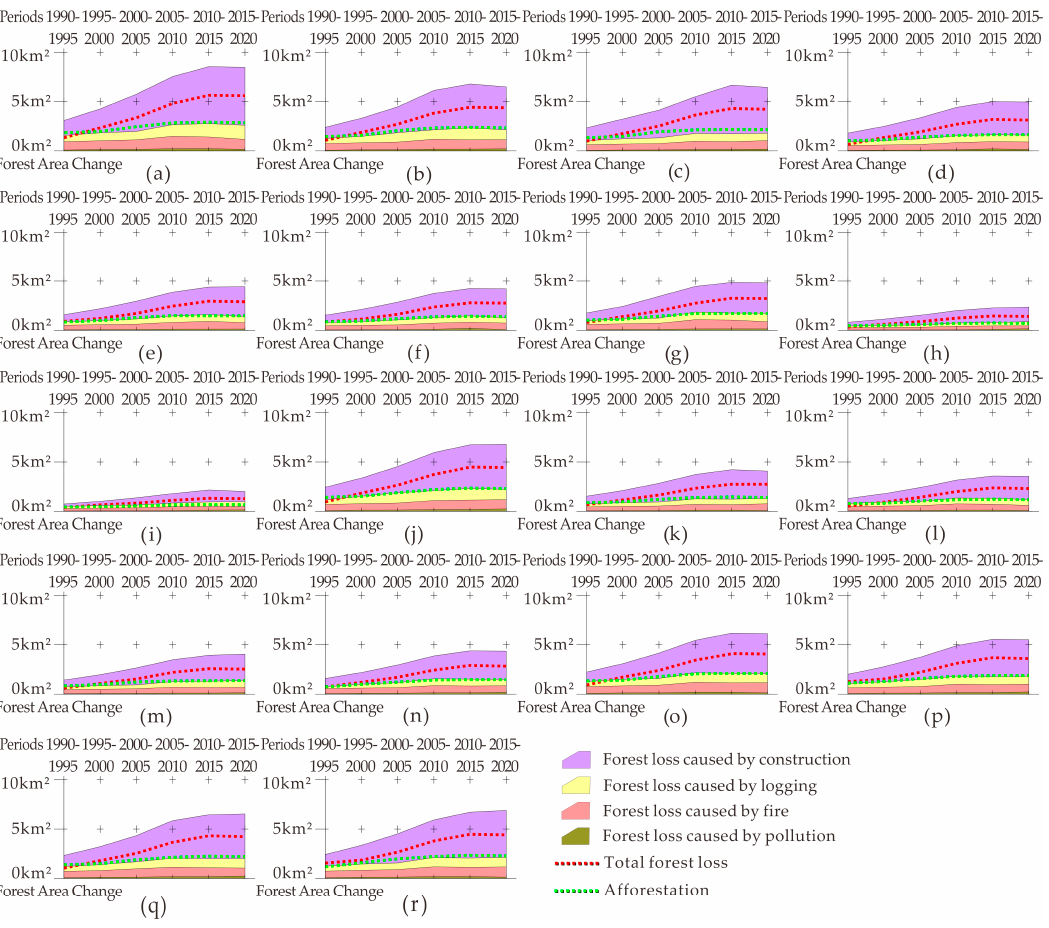
Figure 9. Forest loss curves of 18 cities: ( a ) Xiangyang; ( b ) Jingmen; ( c ) Yichang; ( d ) Jingzhou; ( e ) Yueyang; ( f ) Loudi; ( g ) Hengyang; ( h ) Changde; ( i ) Yiyang; ( j ) Yichun; ( k ) Pingxiang; ( l ) Xinyu; ( m ) Jian; ( n ) Fuzhou; ( o ) Yingtan; ( p ) Jiujiang; ( q ) Jingdezhen; ( r ) Shangrao.